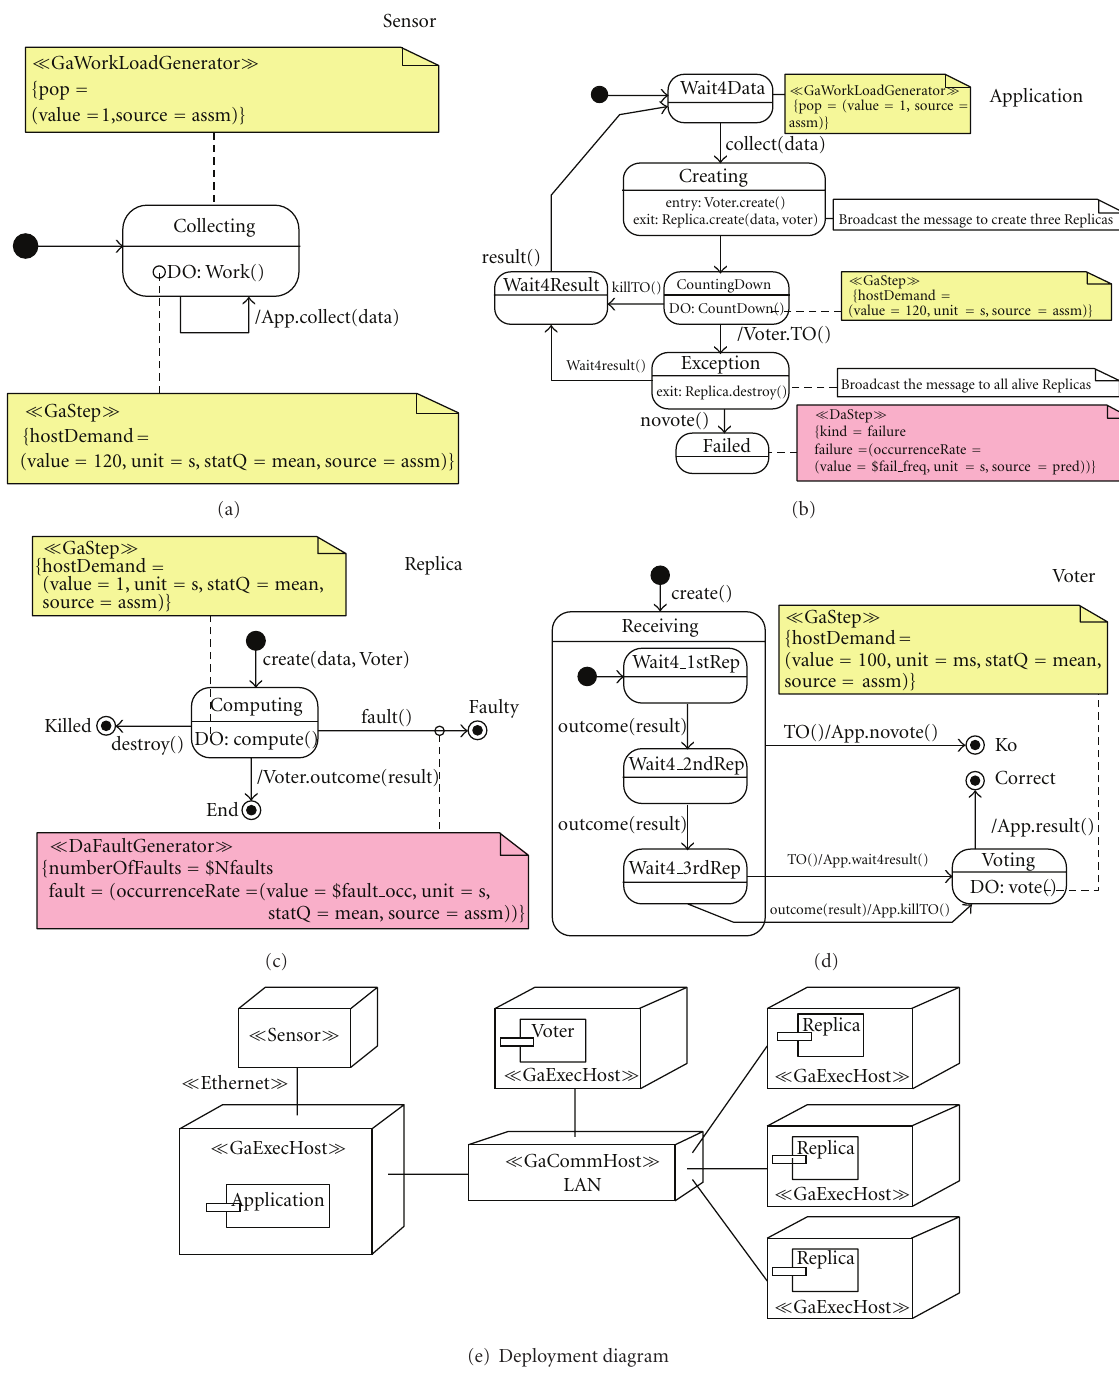
Figure 2: UML design of the